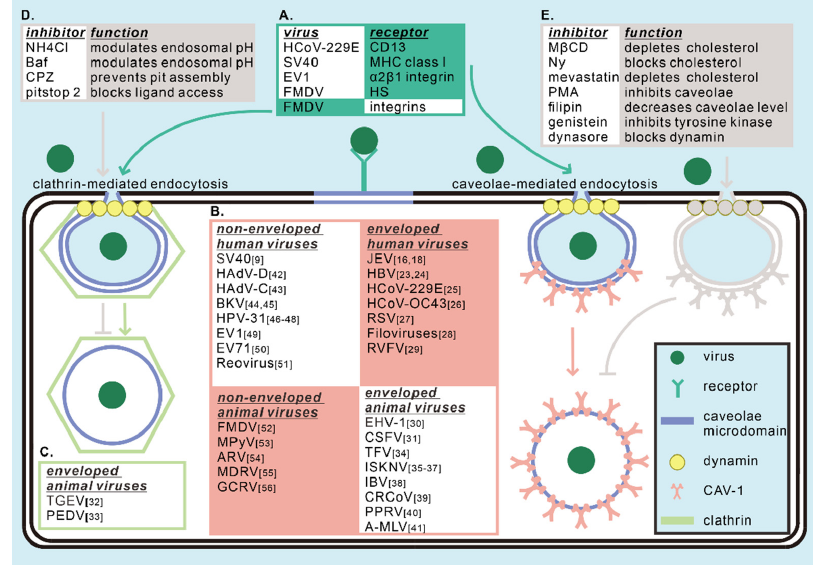
Figure 1. Caveolae/CAV-1 play critical roles in the entry of viruses to the host cells. ( A ) Firstly, the virus binds to a specific receptor in caveolae microdomain. The receptors involved in endocytosis are specifically described and listed. CD13, MHC class I, α 2 β 1 integrin, and HS are involved in caveolae-mediated endocytosis, while integrins participate in clathrin-mediated endocytosis of foot-and- mouth disease virus (FMDV). ( B ) Subsequently, viruses internalize through the caveolae-mediated endocytic pathway are divided into four categories according to their structures and hosts. ( C ) It is noteworthy that transmissible gastroenteritis virus (TGEV) and porcine epidemic diarrhea virus (PEDV) were reported to complete endocytosis by both caveolae- and clathrin-mediated pathways. ( D , E ) Inhibitors of clathrin- and caveolae-mediated endocytosis and their related functions are described and